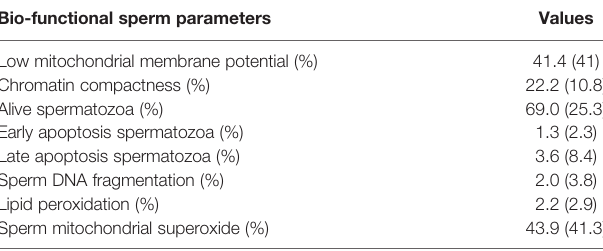
Bio-functional sperm